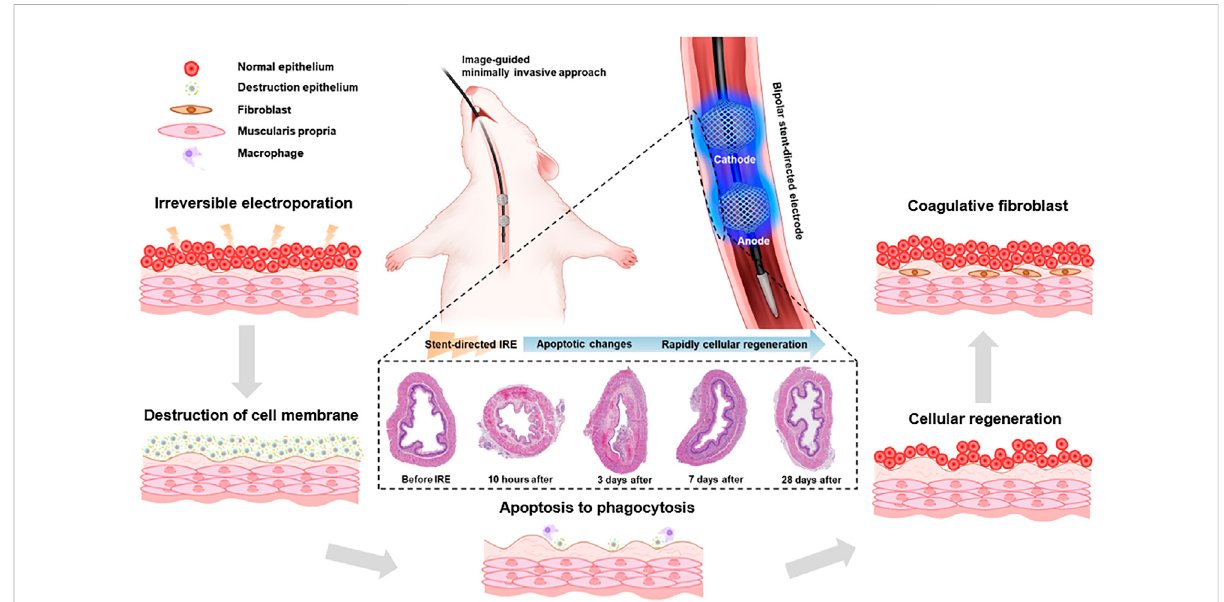
FIGURE 1 Schematic illustration of the stent-directed irreversible electroporation (IRE) system. The newly developed stent-directed IRE system was proven capable of providing a minimally invasive image-guided approach and enhances the IRE-induced therapeutic effects by fully attaching the electrode to the inner wall of the esophagus. The microscopic images show the serial histological changes over